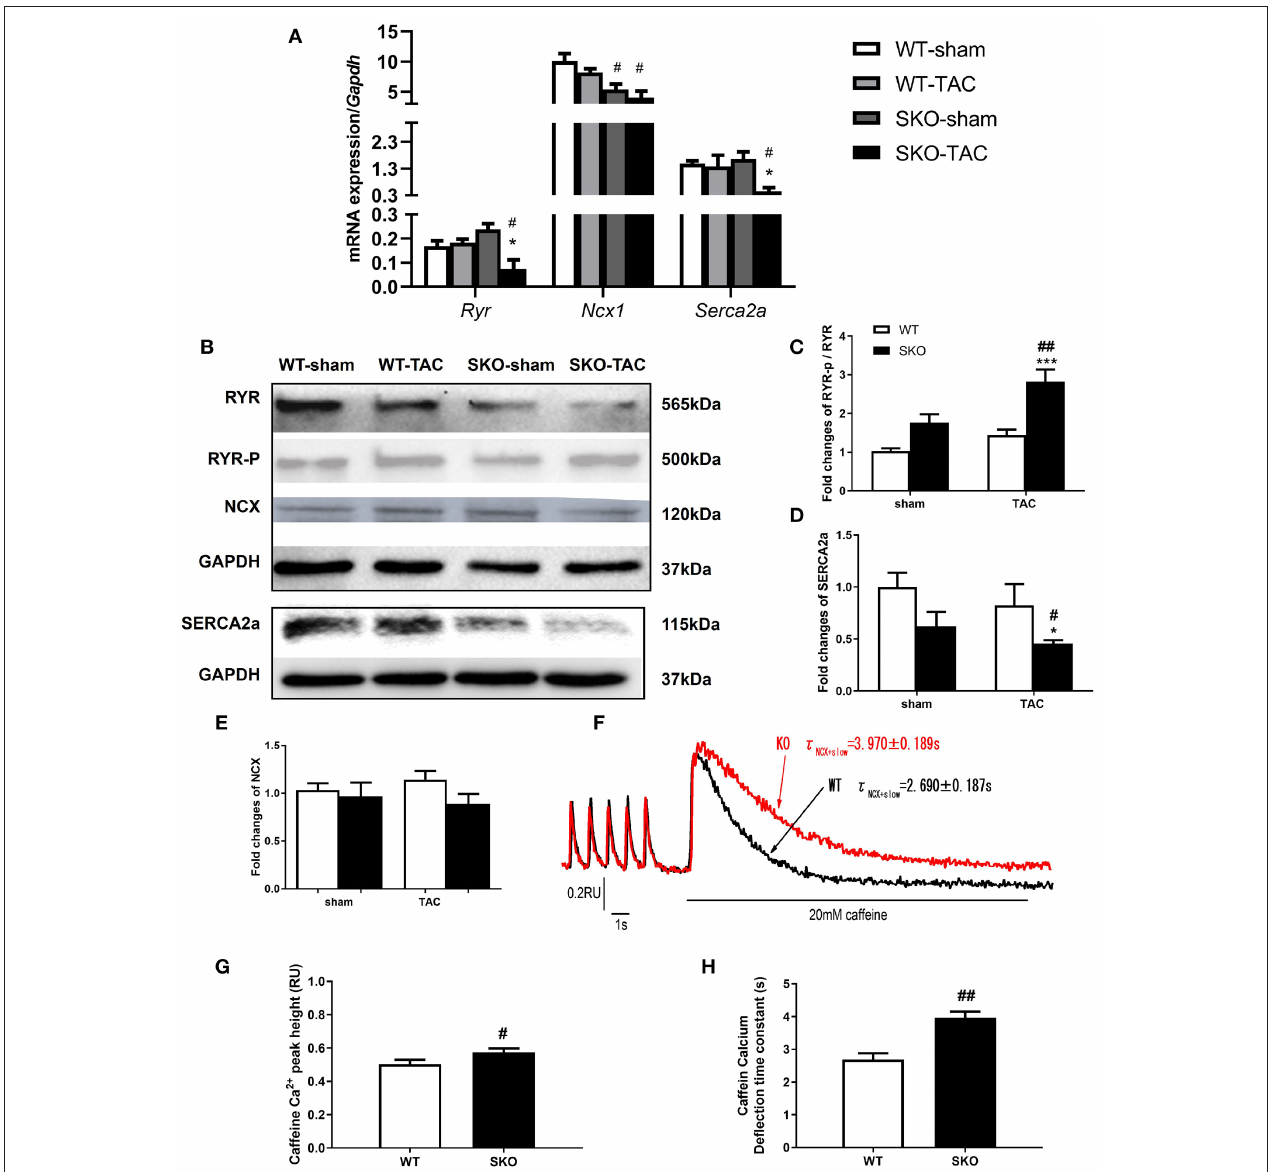
FIGURE 5 | Seipin deficiency induced abnormalities in the calcium handling of ventricular myocytes. (A) mRNA expression levels of Ryr, Ncx1 , and Serca2a ; (B–E) Western blot analysis of RYR, SERCA2a, and NCX and densitometric quantitation; (F) Curve plot of stimulation-induced and caffeine-induced Ca 2 + transient current fluorescence (F340/F380, RU); (G) Peak height of caffeine-induced Ca 2 + release (indicated by the SR Ca 2 + content); (H) Caffeine-induced Ca 2 + transient current deflection time constant (taucaff) (indicating the functionality of NCX in removing diastolic Ca 2 + ). The results are represented as the ratios of the values in the experimental groups to those of the WT control group for RYR and SERCA2a.* P < 0.05, *** P < 0.001, effect of TAC; # P < 0.05, ## P < 0.01, effect of genotype. WT, Wild-type; SKO, Seipin knockout; TAC, transverse aortic